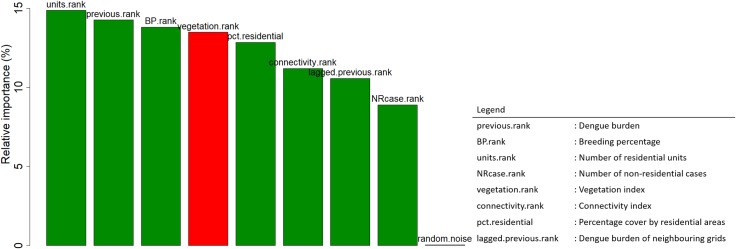
Variable importance plot showing population density, dengue burden and breeding percentage having stronger predictive power than other variables.